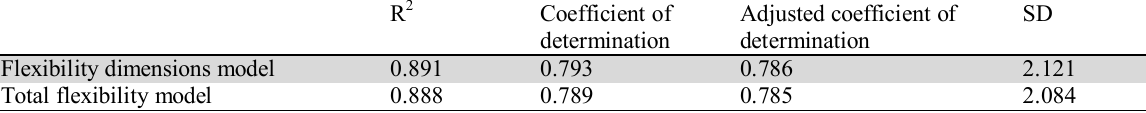
Summary of flexibility model and its dimensions with human resource